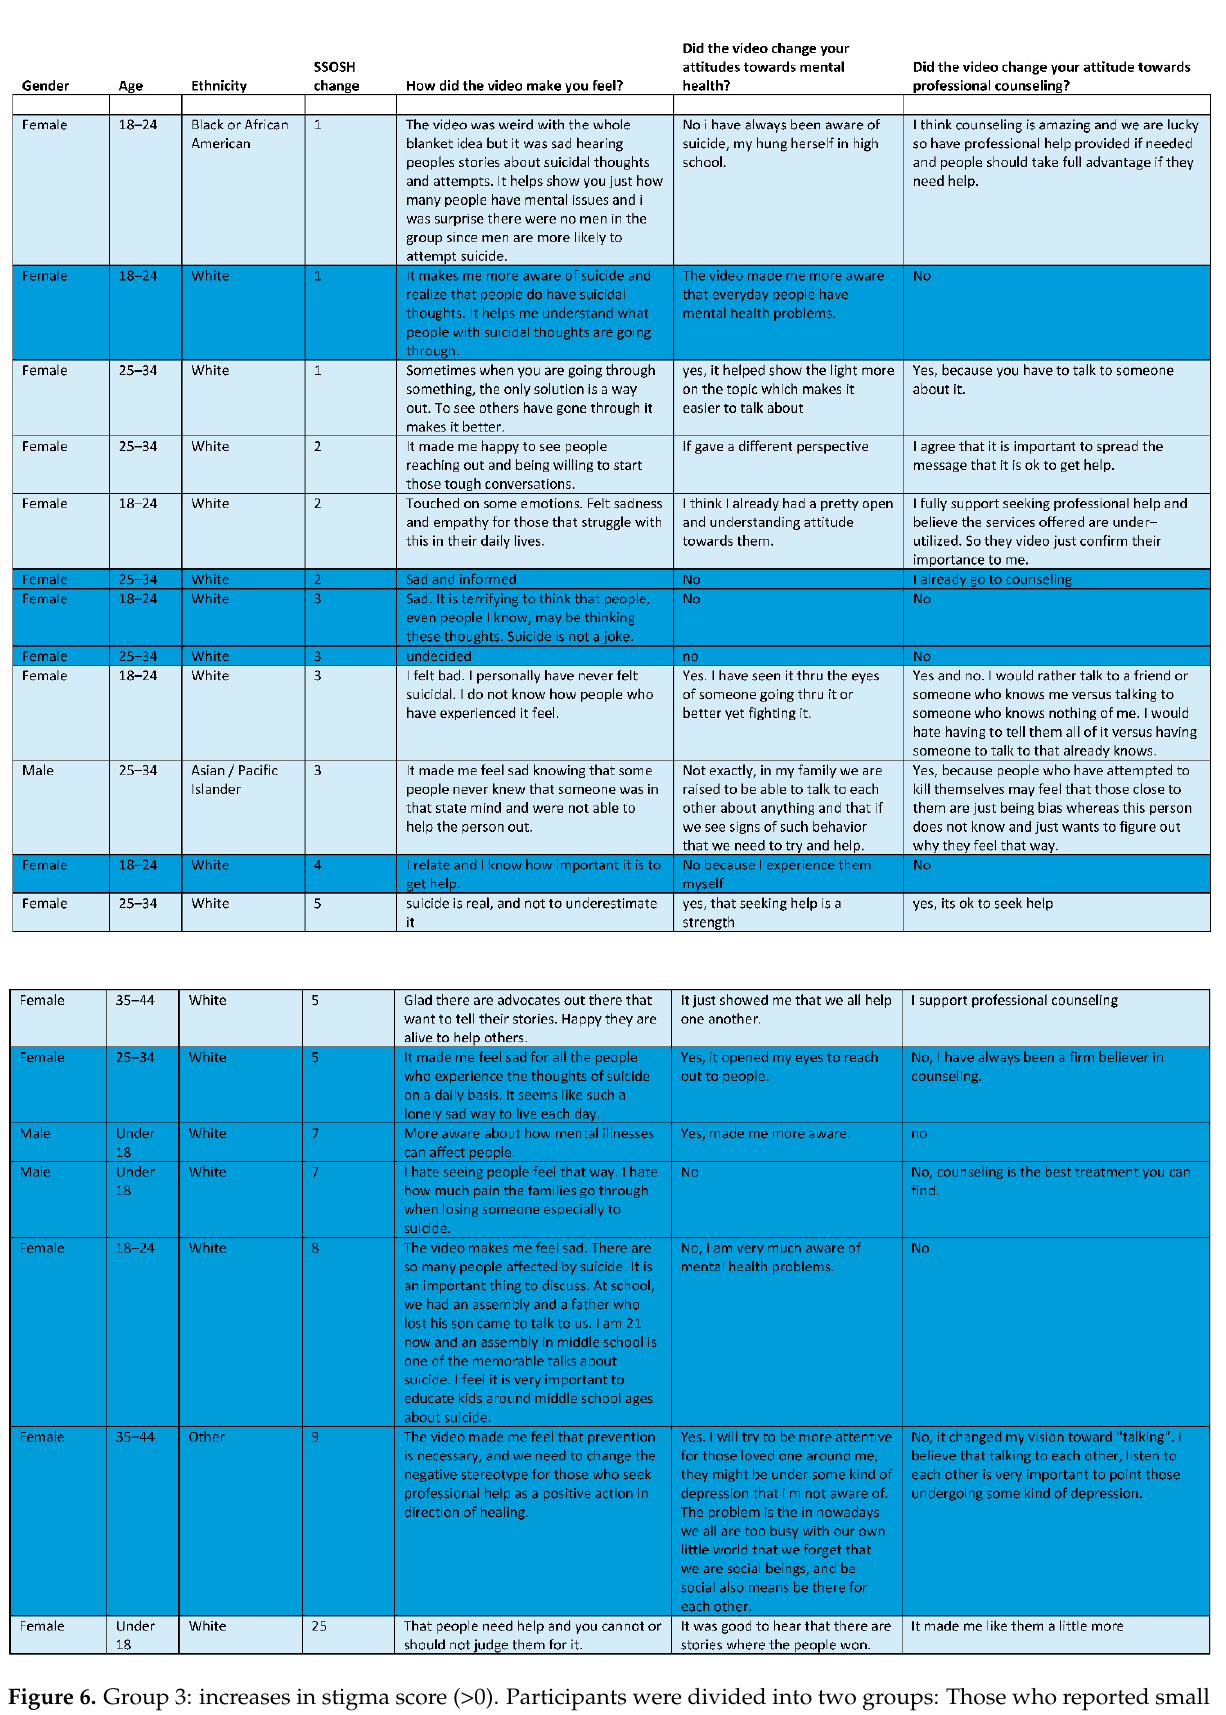
Figure 6. Group 3: increases in stigma score (>0). Participants were divided into two groups: Those who reported small increases in positive attitudes towards counseling (light blue) and those who reported no change (dark blue).